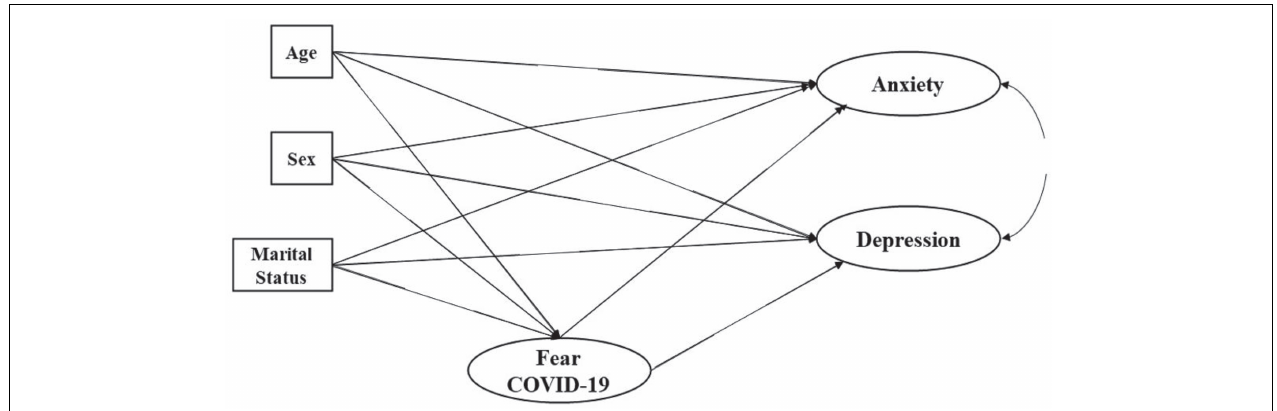
FIGURE 1 | Models of fear of COVID-19 predicting anxiety and depression. A double headed arrow indicates a covariance, whereas single headed arrows indicate a hypothetical predictive effect between two variables.